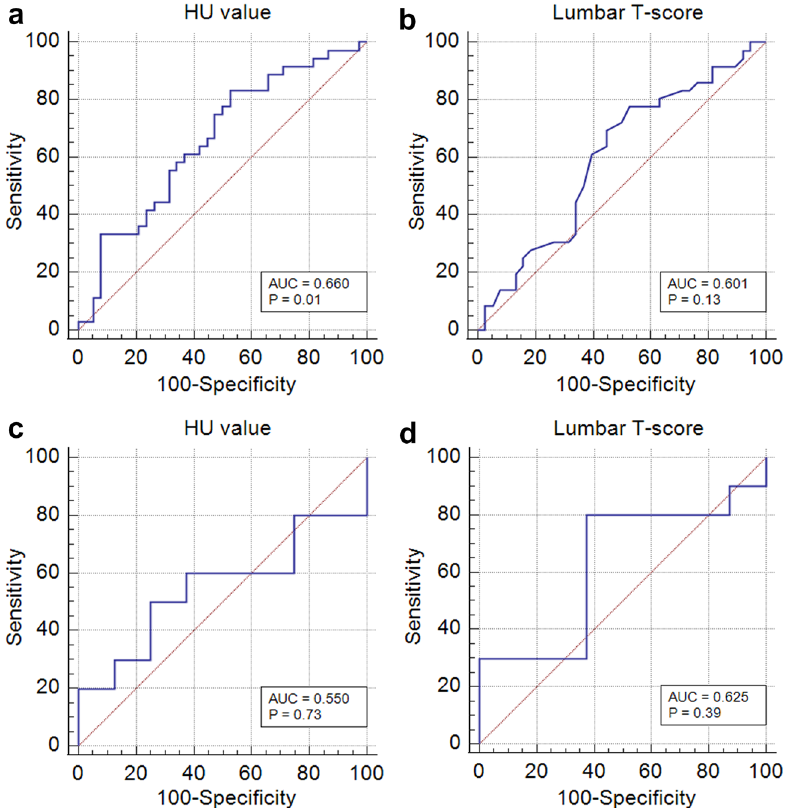
Figure 3. Receiver operating characteristic curves of HU values and lumbar T-scores according to the level of upper instrumented vertebra (UIV): lower thoracic UIV ( a , b ) and upper thoracic UIV ( c , d ). HU, Hounsfield unit; AUC, area under the receiver operating characteristic curve.